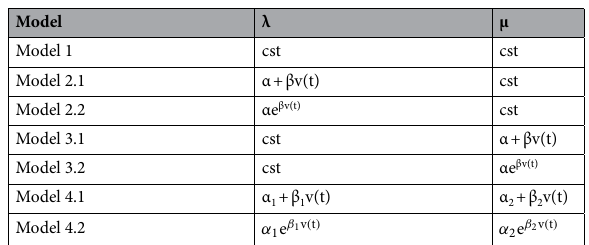
Table 3. Models tested in the environmental birth–death approach. First column describes the model applied on the speciation rate, and second describes the model on extinction rate. The parameters α and β are estimated during the optimization procedure and v ( t ) represents the paleo-environmental